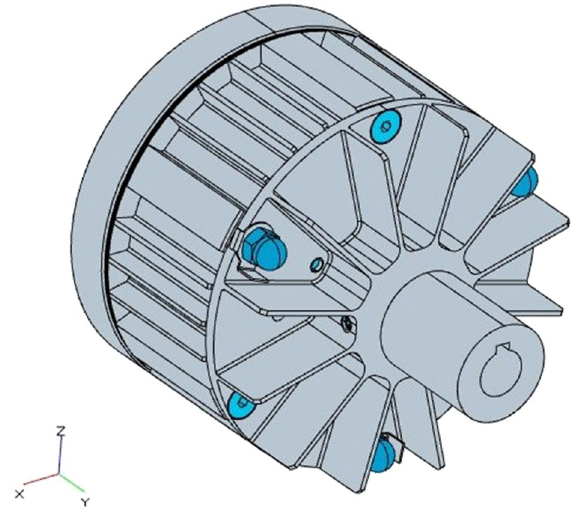
Fig. 1 Sketch of the